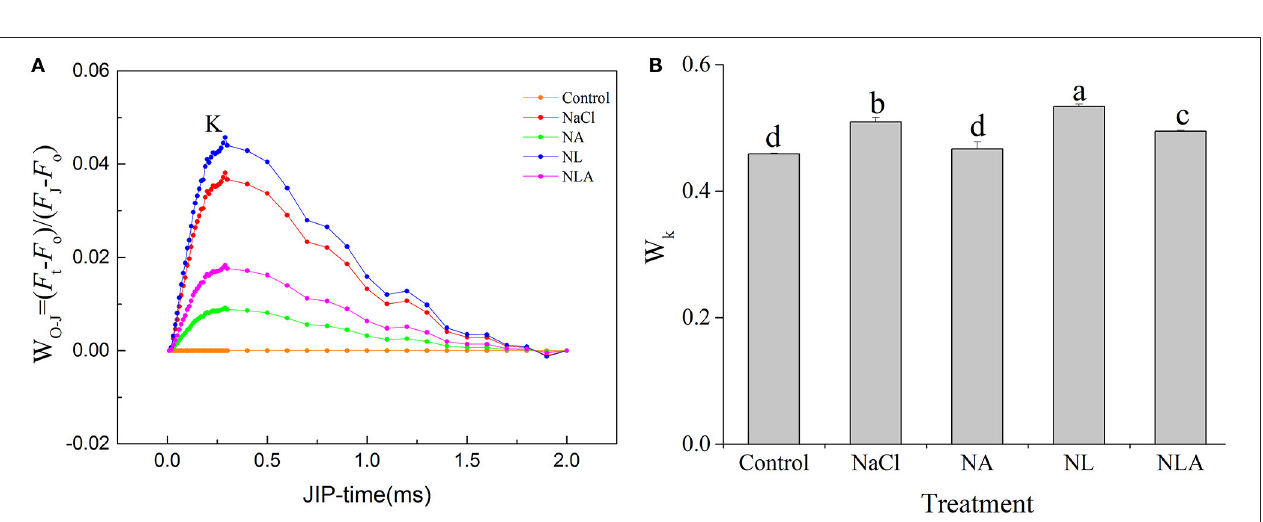
FIGURE 5 | Normalized prompt fluorescence (PF) curves between O and J steps expressed as W O − J = [( F t − F o )/( F J − F o )] (A) and ratio of variable fluorescence F K to the amplitude F J − F O expressed as W K = ( F K − F o )/( F J − F o ) (B) in the leaves of salt-stressed tomato seedlings with or without exogenous ascorbic acid (AsA) and lycorine (LYC) spraying. Values are means ± SD ( n = 3). Different letters (a, b, c, and d) indicate significant difference at P < 0.05 among treatments. Control, no added NaCl, no sprayed AsA and LYC; NaCl, added 100 mmol/L NaCl; NA, added 100 mmol/L NaCl and sprayed 0.5 mmol/L AsA; NL, added 100 mmol/L NaCl and sprayed 0.25 mmol/L LYC; NLA, added 100 mmol/L NaCl and sprayed 0.25 mmol/L LYC and 0.5 mmol/L AsA.